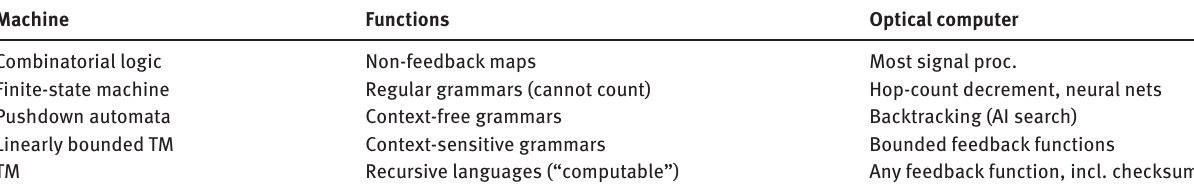
Table 2: Hierarchy of computational models.